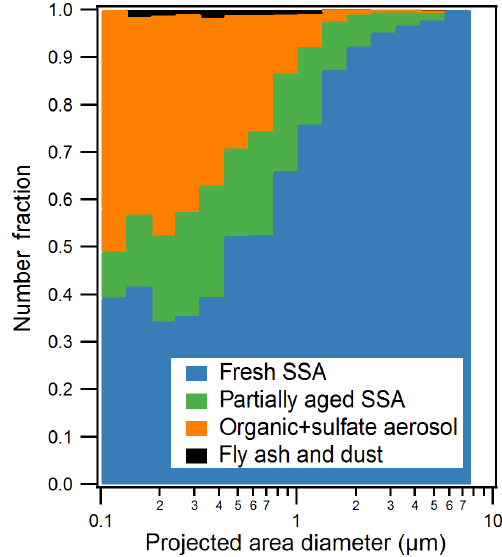
Figure 2. Size-resolved CCSEM-EDX number fraction distribu- tions of observed particle types for all samples. Particles were sorted into 16 bins (logarithmic) from 0.1 to 10.0µm projected area diam- eter (8 bins per decade). Organic + sulfate class includes a small fraction of internally mixed